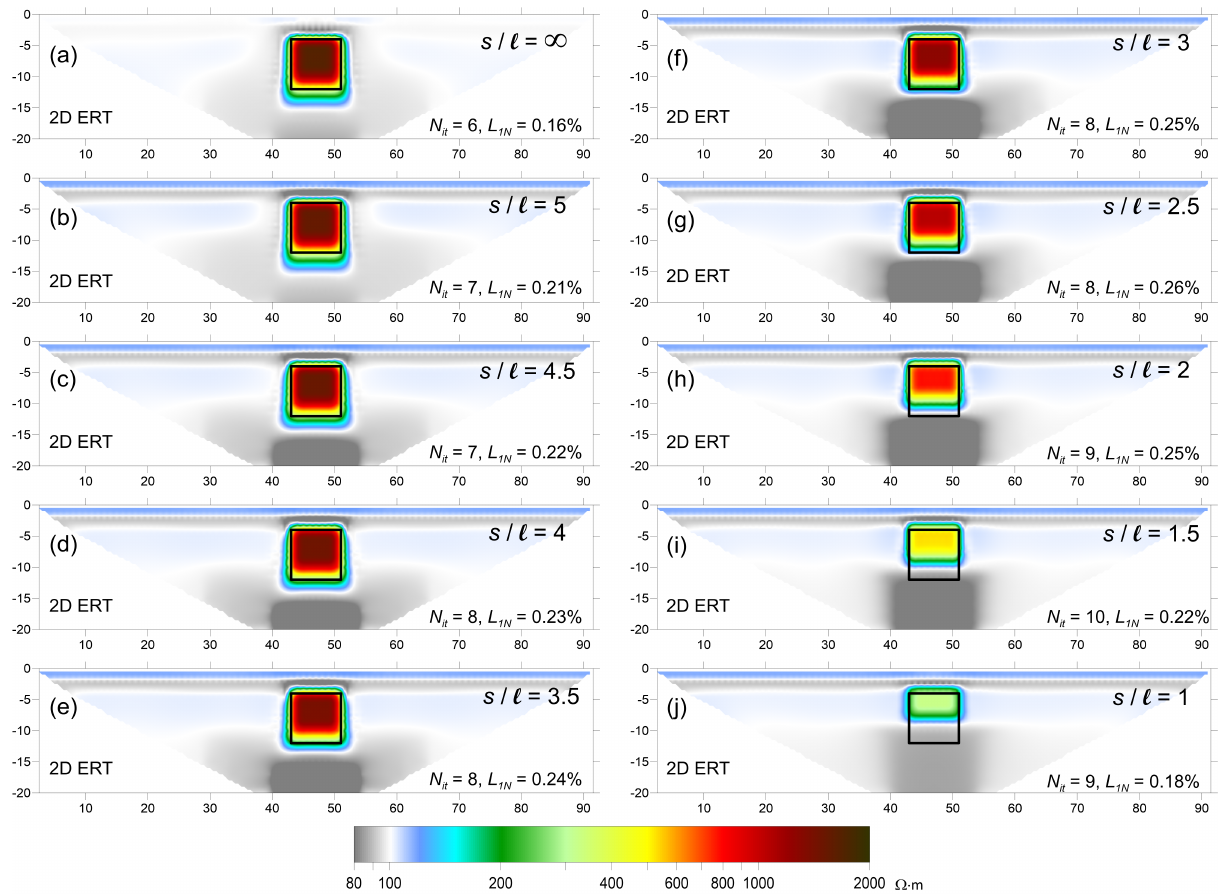
Figure 6. 2D ERT inverse models obtained starting from the 3D models of prism-shaped resistive blocks, with different values for the orthogonal width s of the prism, where ( a ) s / l = ∞ (2D model) and ( b – j ) from s / l = 5 to s / l = 1 (cube model). The orthogonal distance d between the electrode